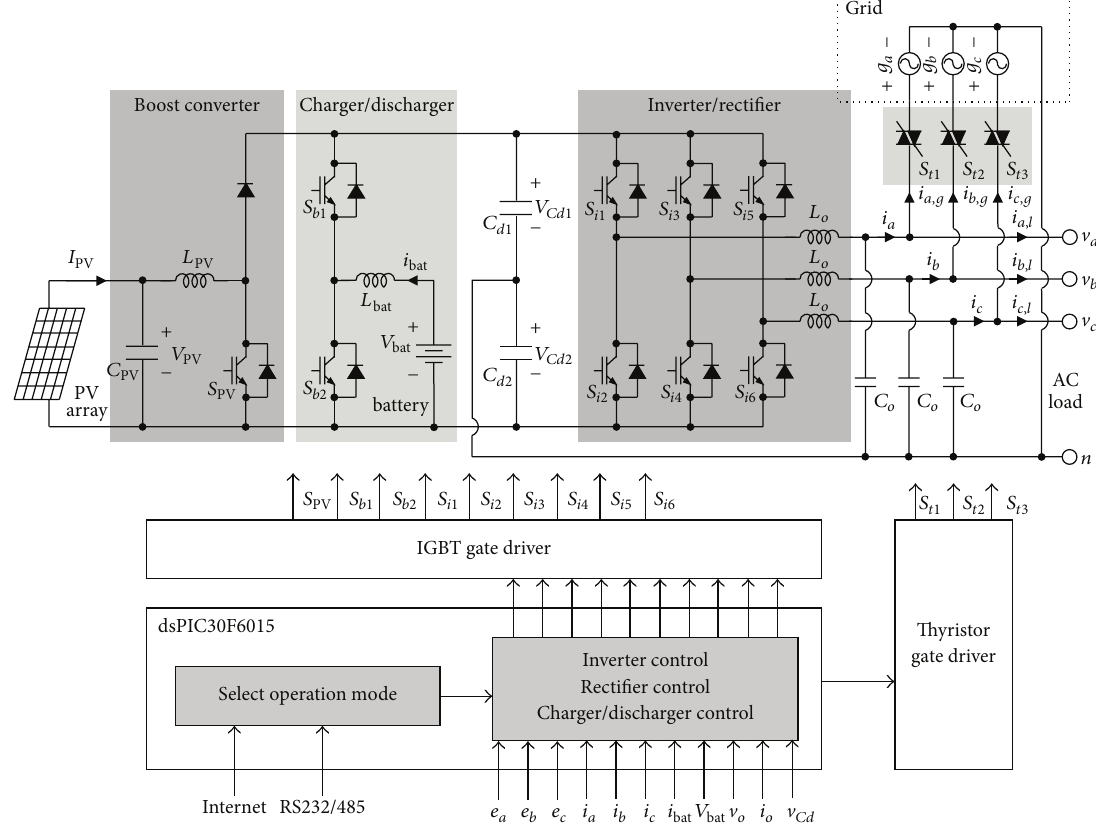
Figure 2: Configuration of the proposed CESS with PV power generation and UPS function.